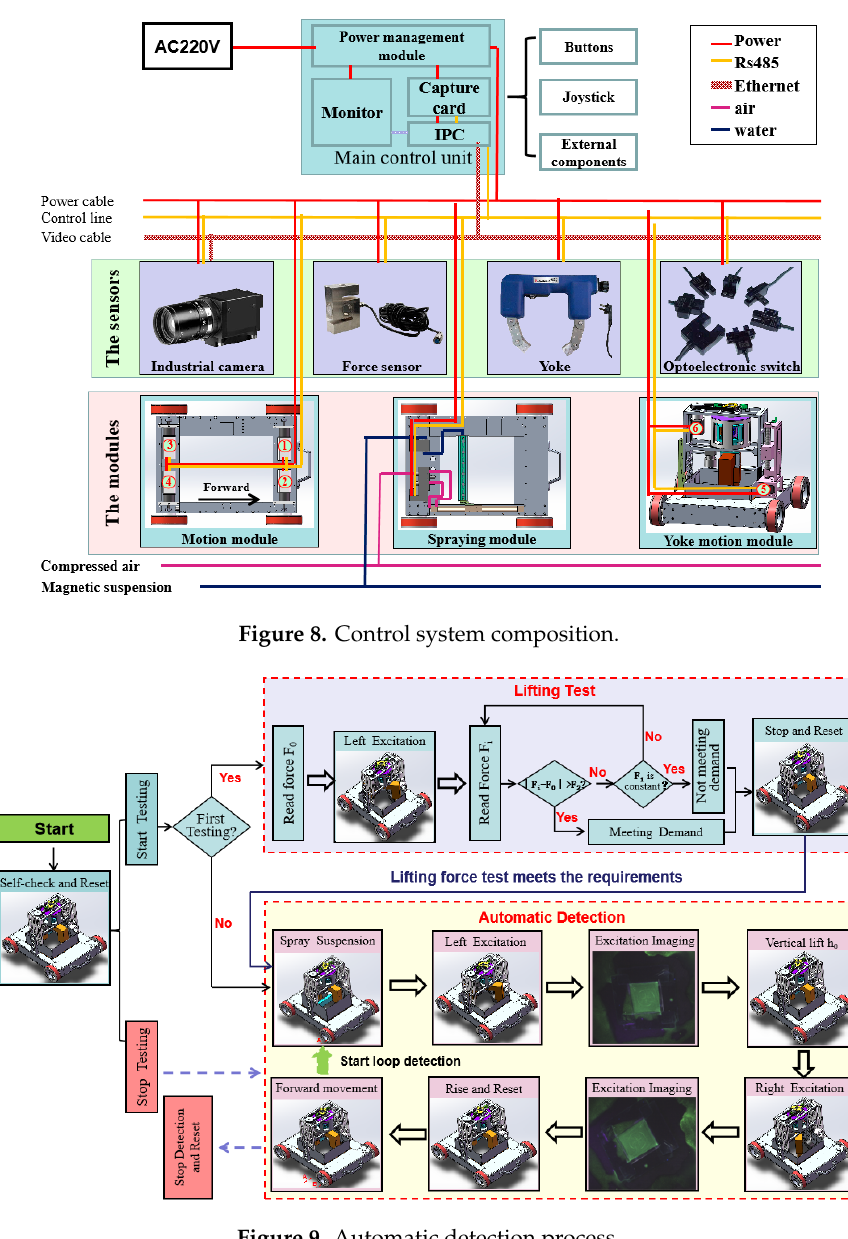
Figure 9. Automatic detection process.